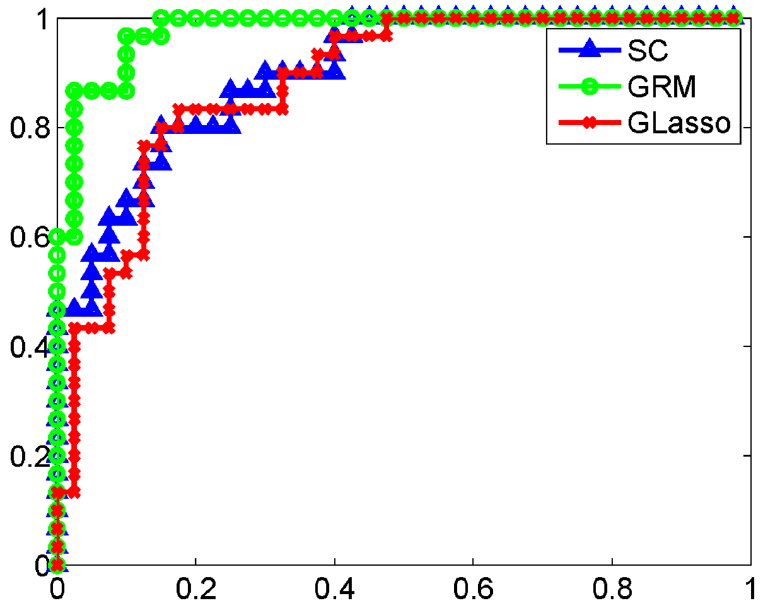
Fig 6. ROC curves of PiB-PET data classification. ROC curves of PiB-PET data classification for the proposed GRM and sample correlation (SC), graphical Lasso (GLasso). When using GRM, we compare the variations of the testing data point on the graphs learned from the training data of the AD group and NC group, respectively. When using SC or GLasso, we compare the Mahalanobis distances or the likelihood of the new data point under the two Gaussian graphical models, accordingly. The GRM significantly outperforms the other two methods.